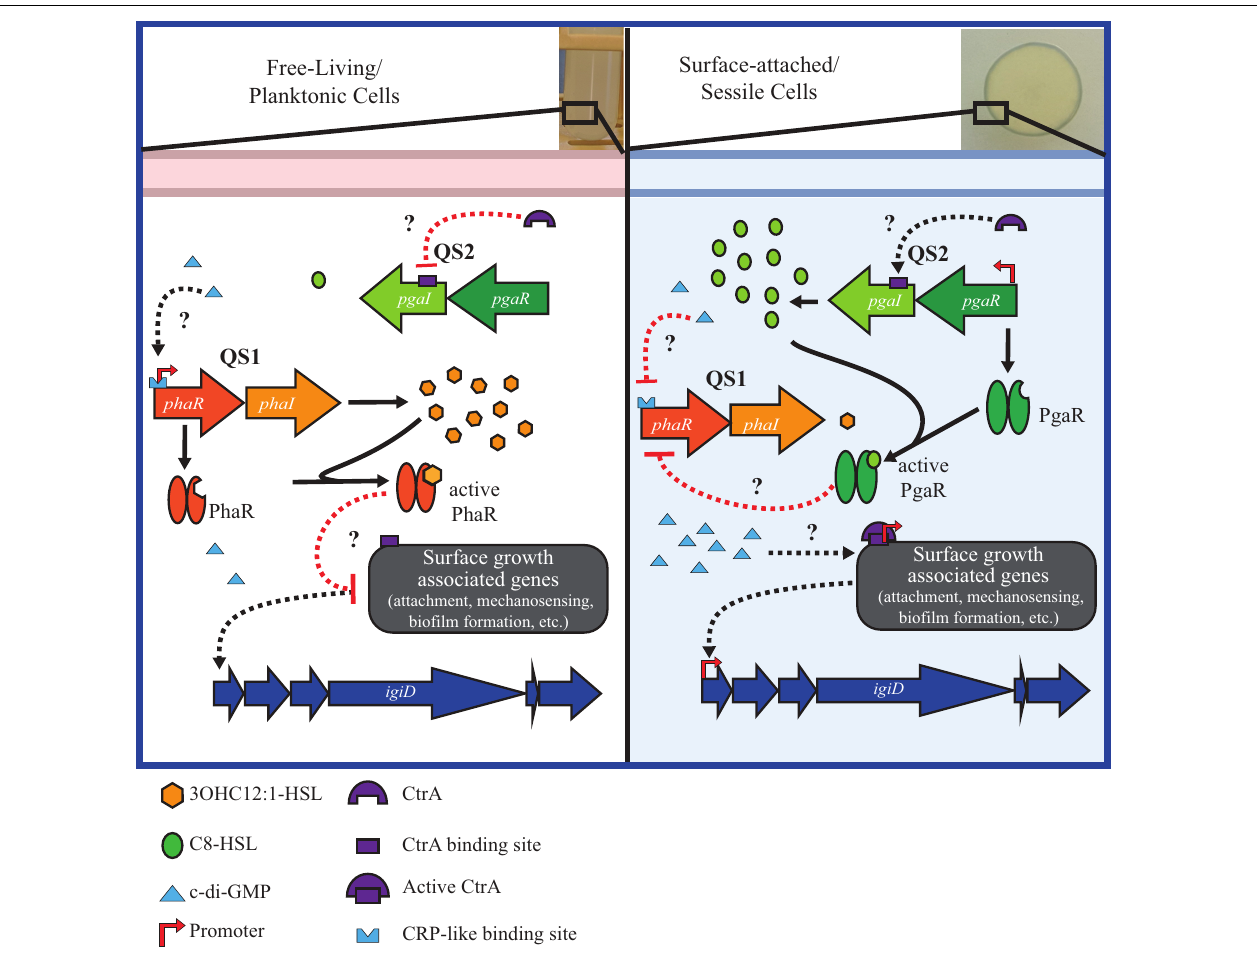
FIGURE 5 | Working model of the regulatory network governing key physiologies in strain Y4I. Left panel shows genetic regulation during growth at low cell densities when Y4I is growing planktonically. During this growth modality, 3OHC12:1-HSL (QS1) concentrations are highest and we hypothesize that surface growth associated genes (e.g., mechanosensing, attachment, biofilm formation, flagella biosynthesis, and/or ctrA phosphorelay) are repressed, either directly or indirectly through QS1. Right panel shows genetic regulation during growth on a surface. It is predicted that when concentrations of C8-HSL are highest, QS2 represses expression of QS1, either directly or indirectly, allowing for the transcription of surface growth associated genes. Both c-di-GMP and CtrA are expected to play a role in activating surface-growth associated genes, though the specific mechanism of this regulation is currently unknown. Black lines are indicative of activation while red represents inhibition. Solid lines represent known pathways, while dotted lines are